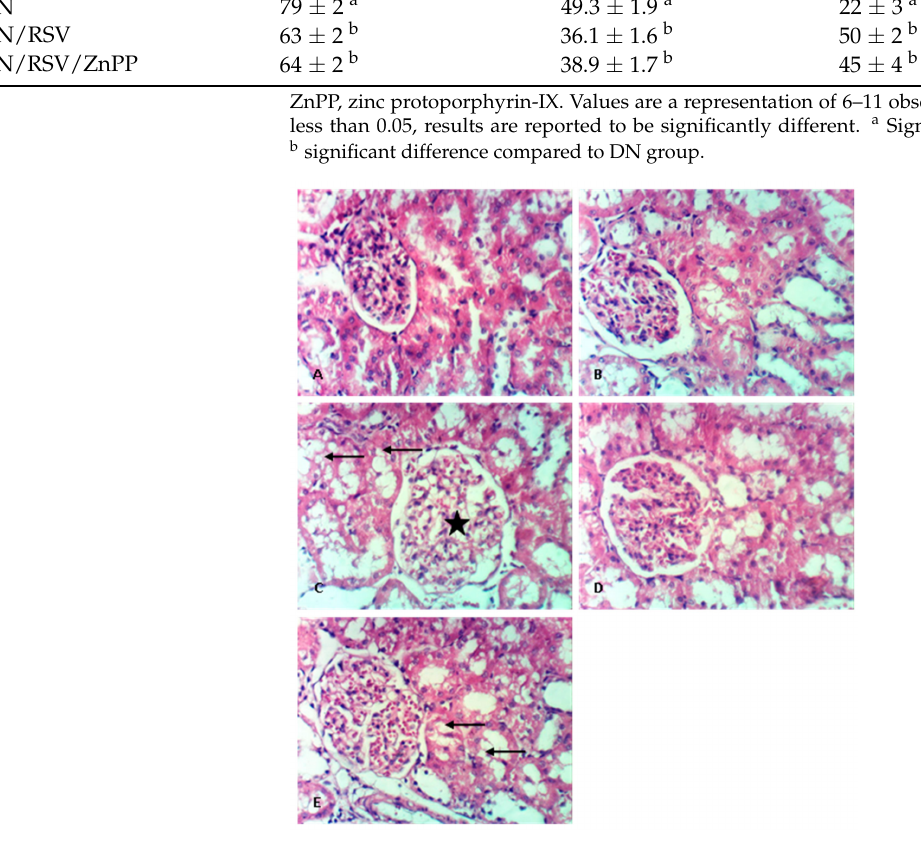
Figure 1. Effect of rosuvastatin (RSV) on renal histopathological changes in diabetic nephropathy (DN) in rats. Rat renal photomicrographs (400 × ) of ( A ) control, ( B ) RSV, ( C ) DN, ( D ) DN/RSV and ( E ) DN/RSV/zinc protoporphyrin-IX groups. Black arrow: vacuolation of epithelial lining renal tubules; star: distorted glomerulus. Table 4. Effect of rosuvastatin (RSV) on renal histopathological picture scoring in diabetic nephropa- thy (DN) in